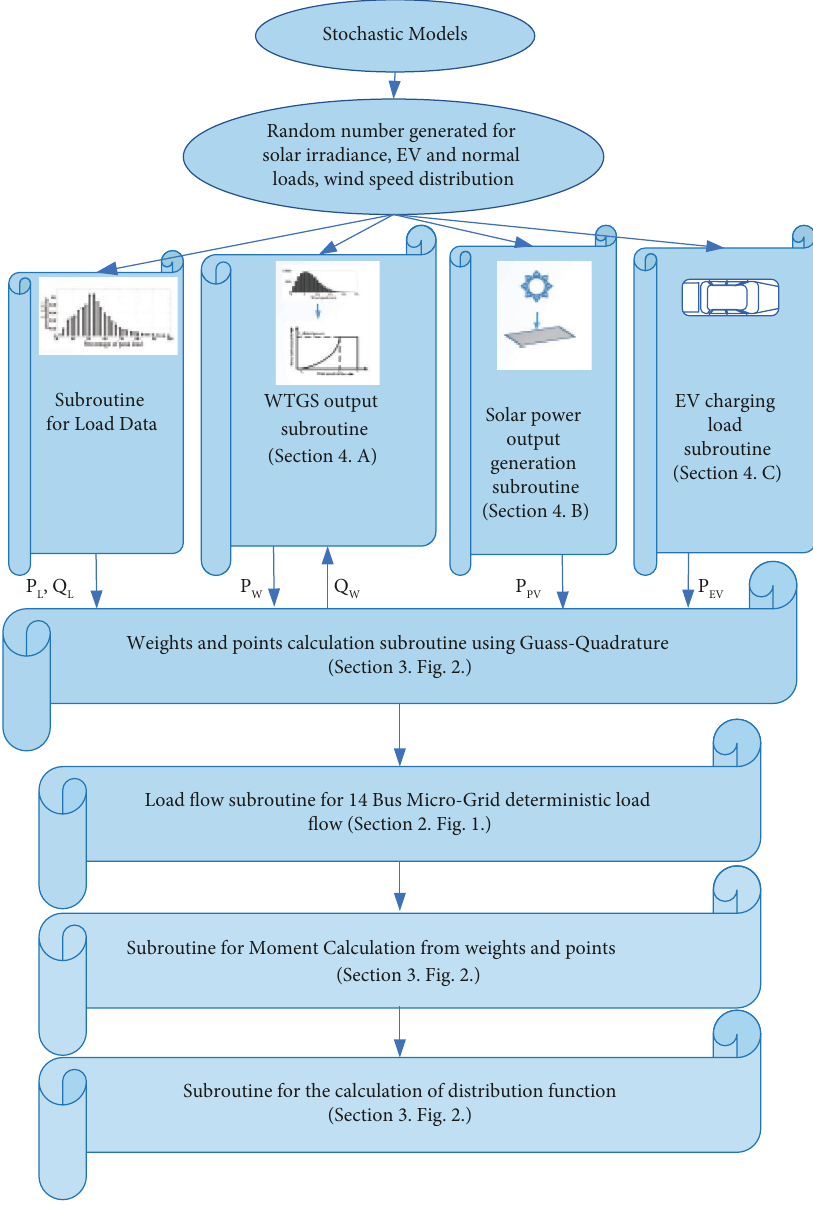
Figure 3: Adopted methodology and simulation